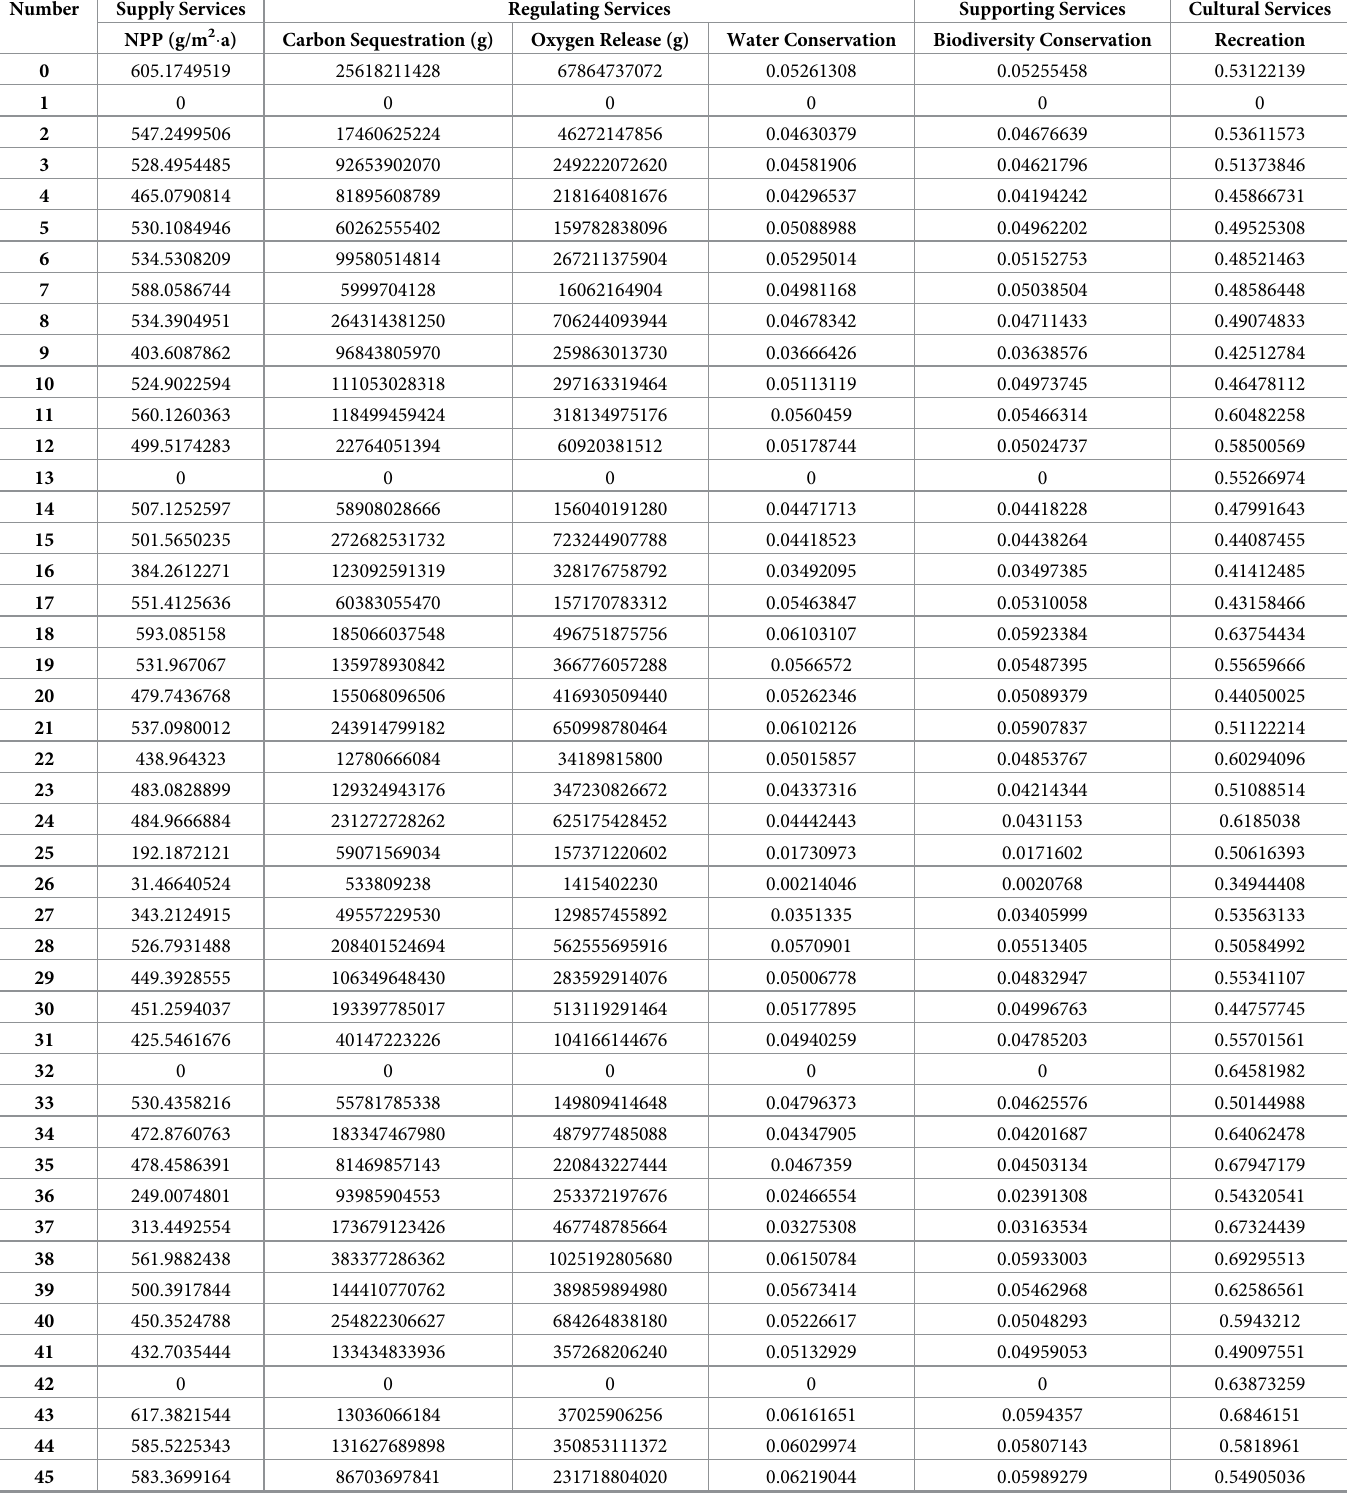
Table 3. Forest ecosystem service functions of the study